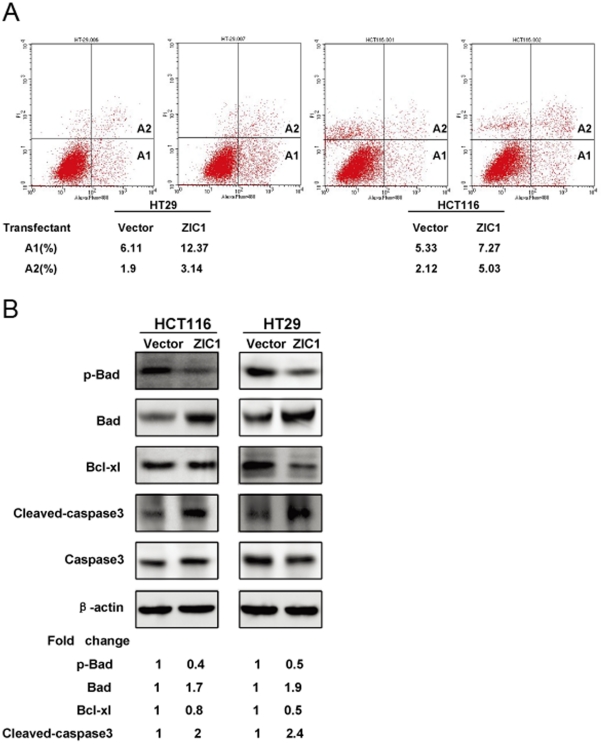
Ectopic expression of ZIC1 induces cell apoptosis and modulates Bcl-xl/Bad/Caspase3 cascade.(A) Cell apoptosis was detected by the Annuexin V-PI flowcytometry assay. The representative figures are shown after transiently transfected with ZIC1 or control vector after 48 hours in HT29 and HCT116 cells. Region A1 indicates early apoptotic cells, A2 shows late apoptotic cells. (B) Western blot analysis of apoptotic regulated proteins. The expression of phospho-Bad and Bad, Bcl-xl, Cleaved-caspase3, and Caspase3 were detected after transected with ZIC1 or control vector in colon cancer cell lines (HT29 and HCT116). Band densities were quantified and protein levels (p-Bad, Bad, Bcl-xl, and Cleaved-caspase3) were normalized to β-actin. Densitometry values (ZIC1 transfectants) are expressed as fold change compared with vector transfectants values normalized to 1.